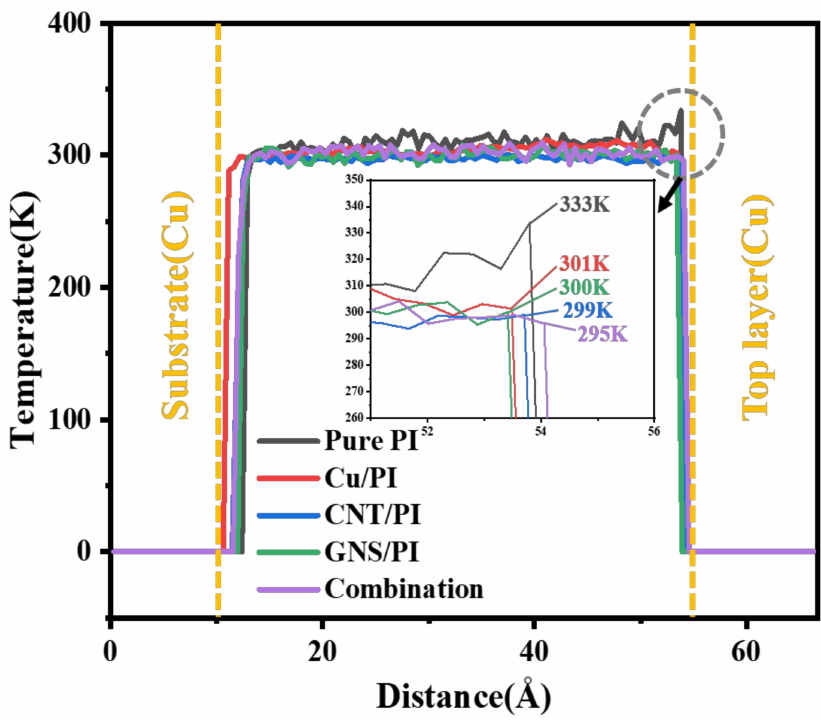
Figure 12. Temperature profiles of friction